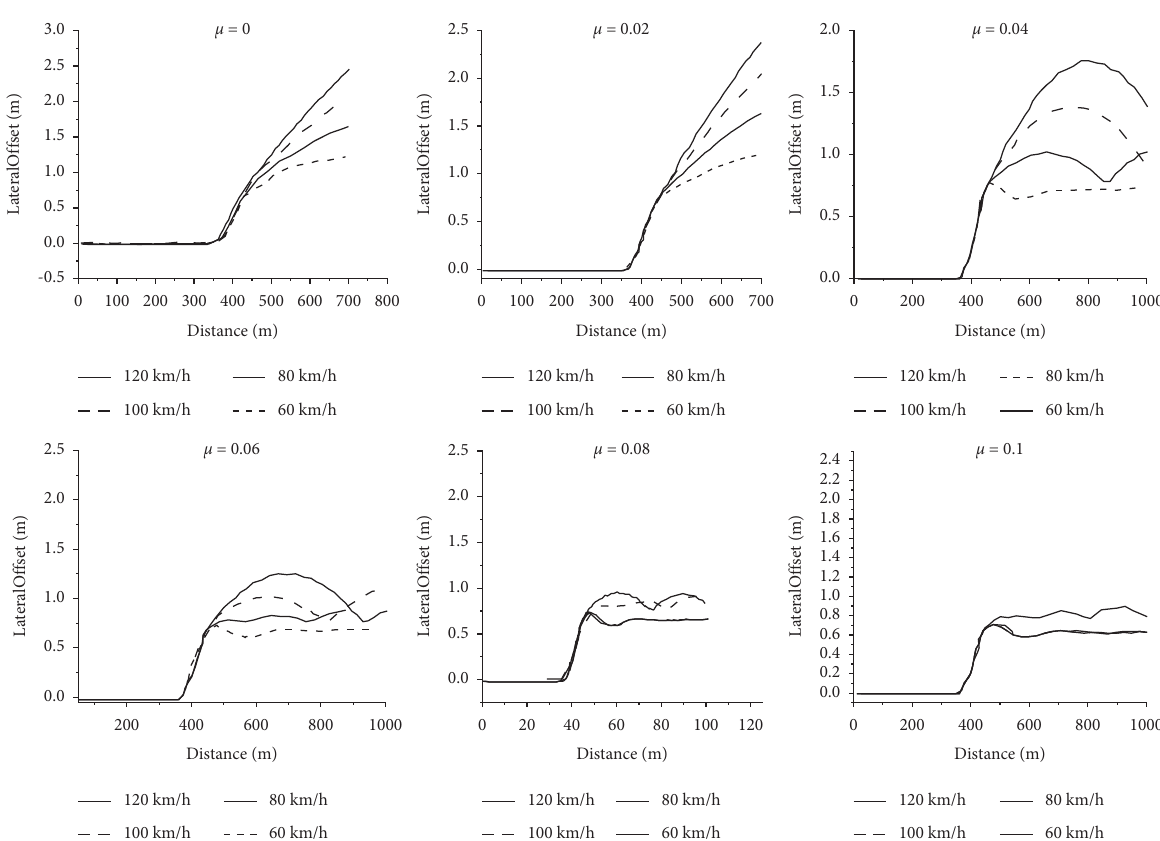
� 1.025 mm; µ refers to friction coefficient between m